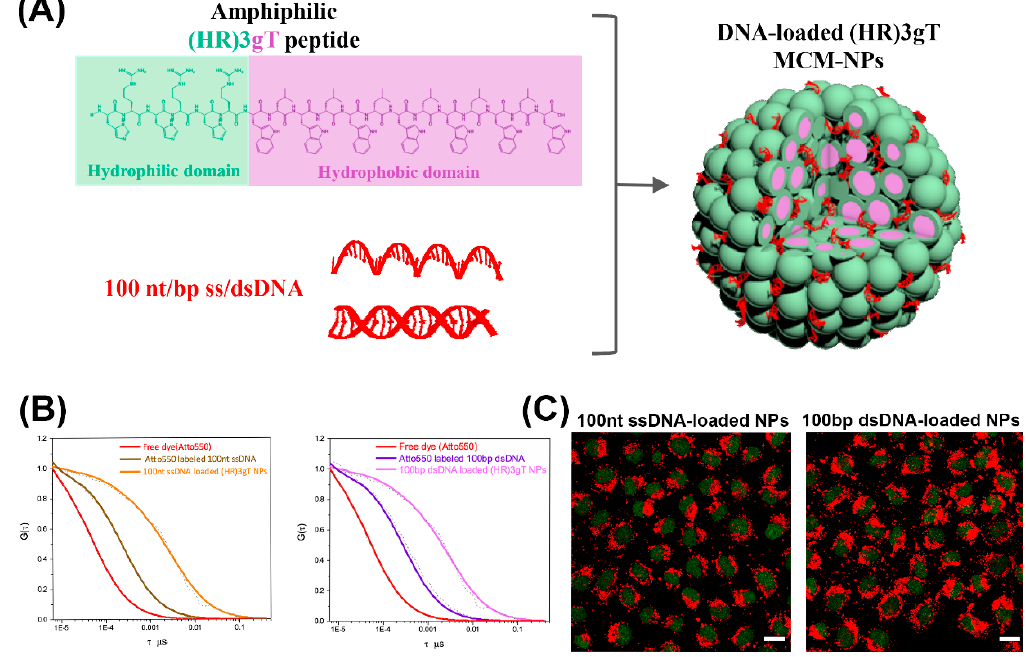
Figure 2. ( A ) Schematic illustration of amphiphilic (HR) 3gT peptide comprising a hydrophilic (green) and a hydrophobic (light purple) domain, and the self-assembled multi-compartment micelle nanoparticle. ( B ) Normalized fluorescence correlation spectroscopy (FCS) autocorrelation curves for fluorescently labelled 100 nt ssDNA and 100 bp dsDNA (free and loaded in multi-compartment micelles). ( C ) Confocal laser scanning microscopy (CLSM) merged images (GFP and Atto550) of H2B-GFP expressing HeLa cells treated with 100 nt/bp ss/dsDNA-loaded (HR)3gT multi-compartment micelle nanoparticles after 24 h. Adapted and modified from [40], with permission. Copyright: 2020 Royal Society of Chemistry.